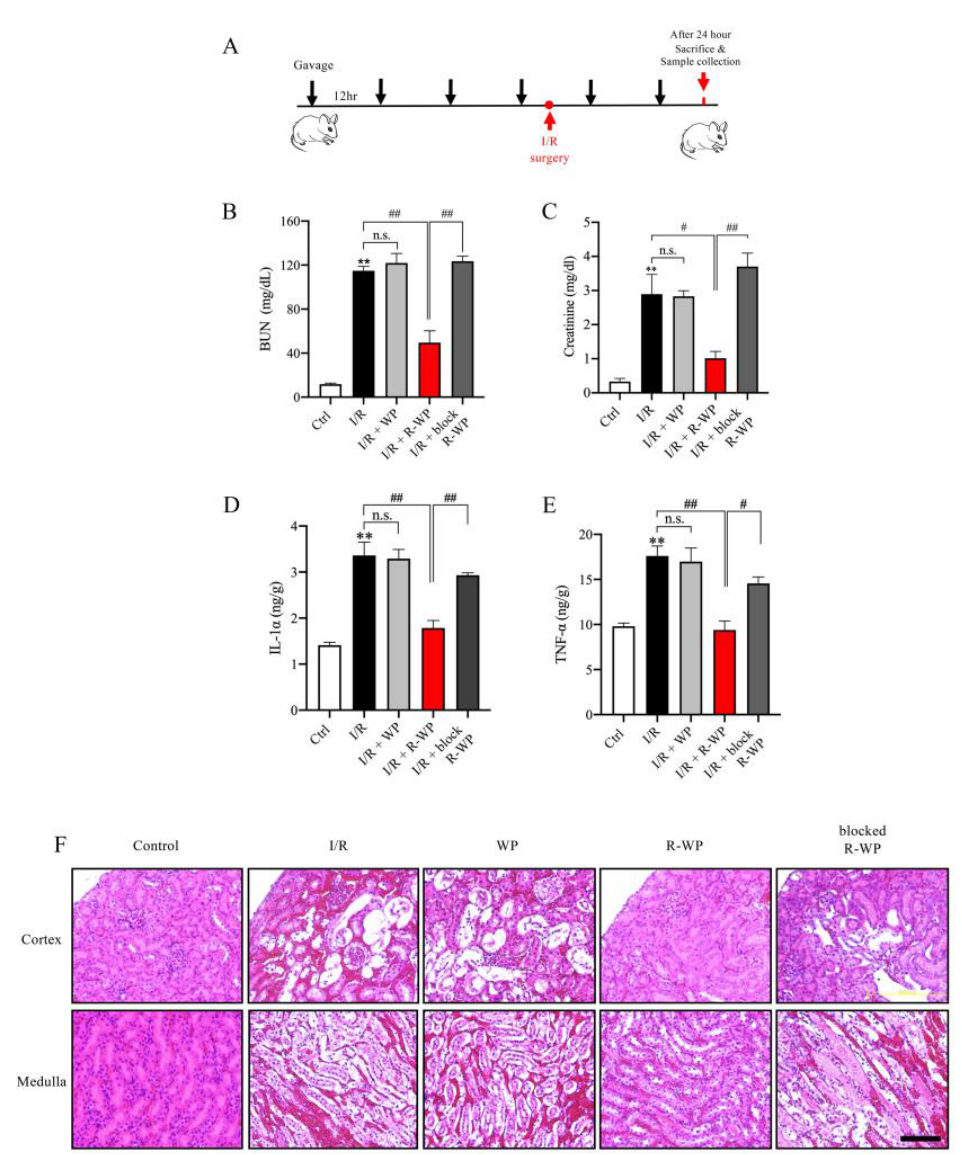
Figure 4. R-whey ameliorates I/R-induced changes in renal function, inflammation, and structure. ( A ) Schematic depiction of the experimental design. ( B – E ) Effect of WP treatment on renal function and inflammation. The blood collected from differently treated groups was assayed for BUN, creatinine, and inflammatory mediators. Data shown are mean ± SE ( n = 4; n.s.: not significant; ** p < 0.01 vs. Ctrl; # p < 0.05; ## p < 0.01 vs. R-WP group). ( F ) Effects of WP treatment on the renal structure. Representative images of HE staining of the renal section are shown. Note that I/R induced noticeable changes in renal tubular dilation, the disappearance of the tubular brush board, and the detachment of renal tubular cells in control and its prevention by R-WP. Scale bar, 10 µ